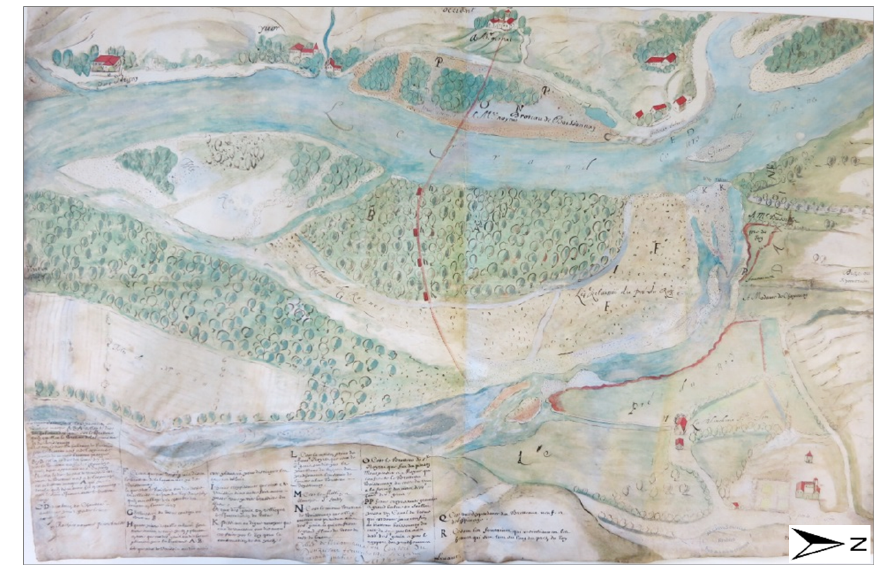
Figure 5. Map at ∼ 1:10000 between Pierre-Bénite and Irigny, 1644 (source: Maupin, AD Rhône, 44 J 336).